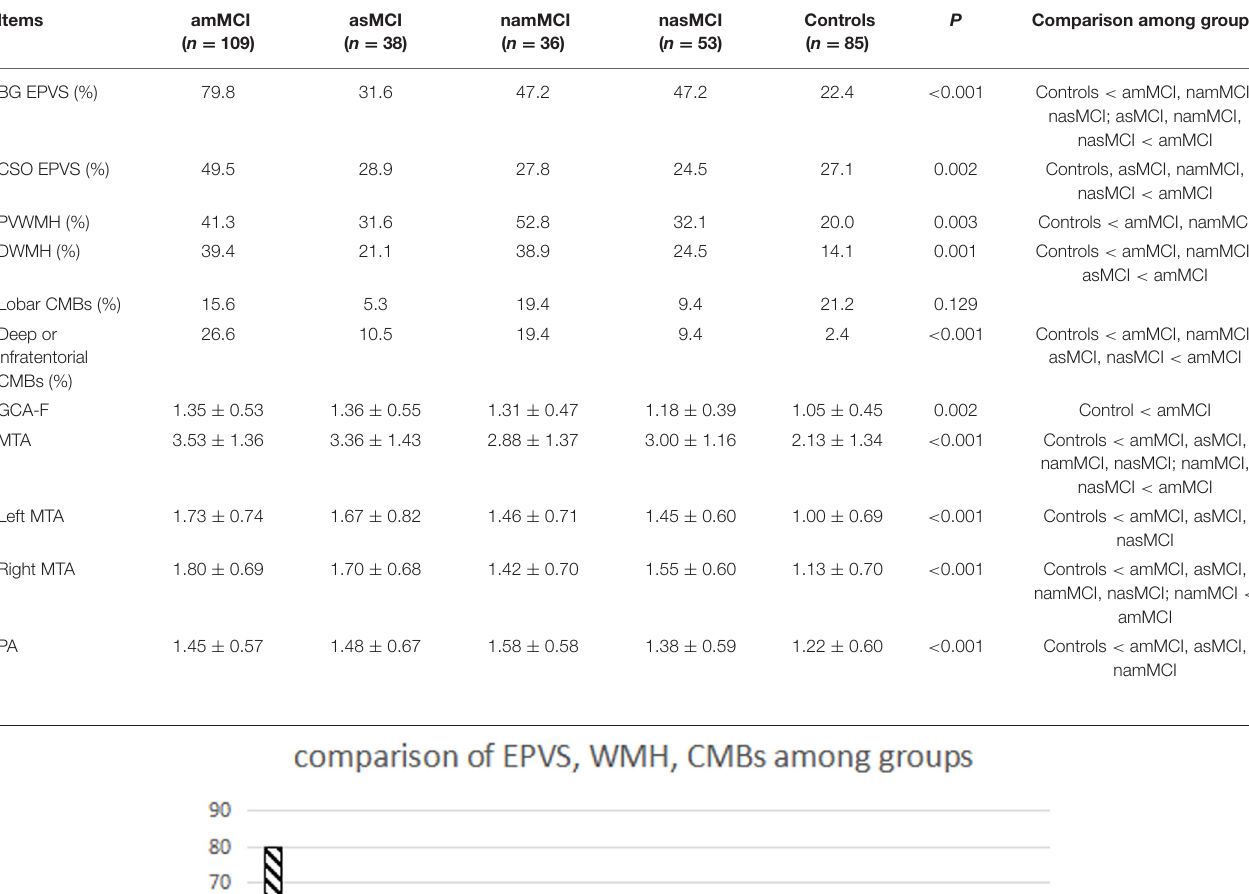
TABLE 2 | Imaging data of the patients with different MCI subtypes and the healthy controls. Items